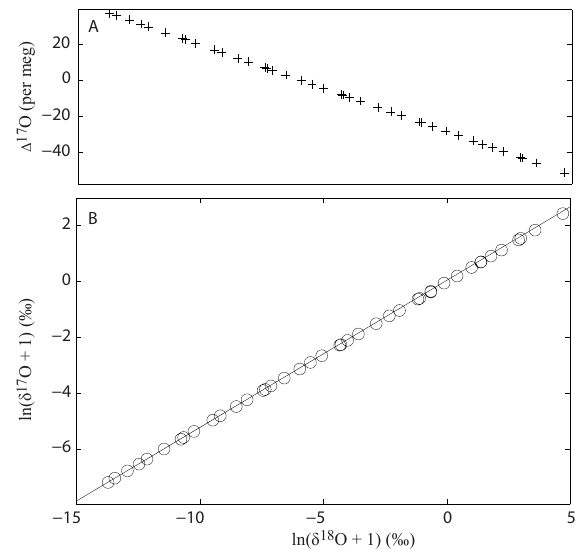
Figure 10. Results of an evaporation experiment in which 2mL sample vials are left open to the ambient air and are progressively sampled (ten 1.8µL injections for each vial) over a ≈ 60h period. (A) δ 17 O vs. ln (δ 18 O + 1 ) , (B) ln (δ 17 O + 1 ) vs. ln (δ 18 O + 1 ) . Time progress to the right in both panels. Note the gradual deviation of the measurements (open circles) from a slope of 0.528